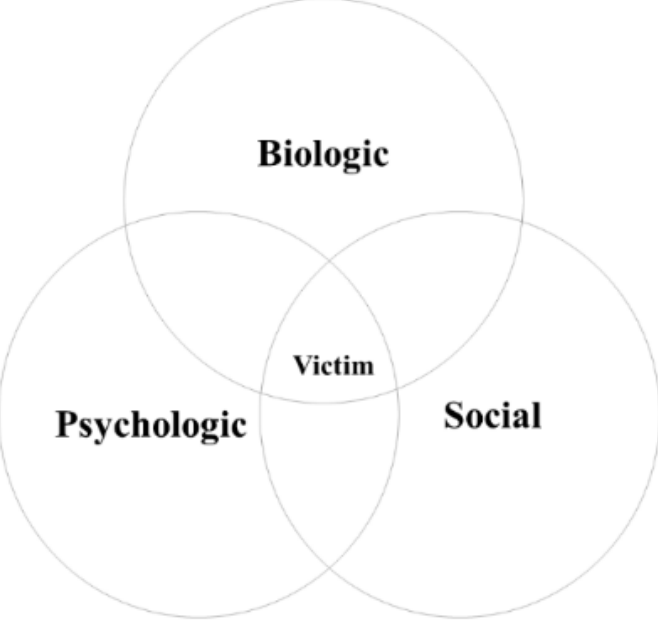
Figure 1. Biopsychosocial model